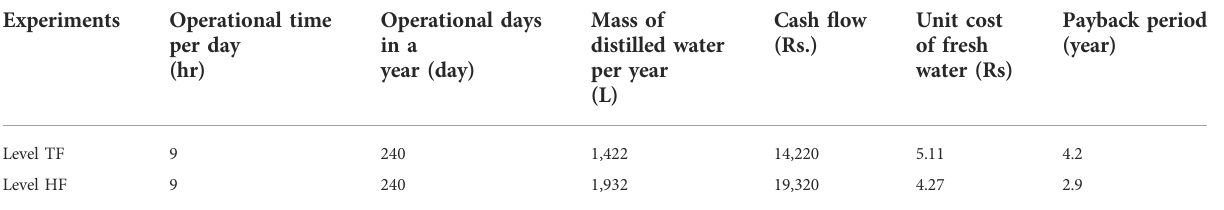
TABLE 6 Economic analysis parameters.